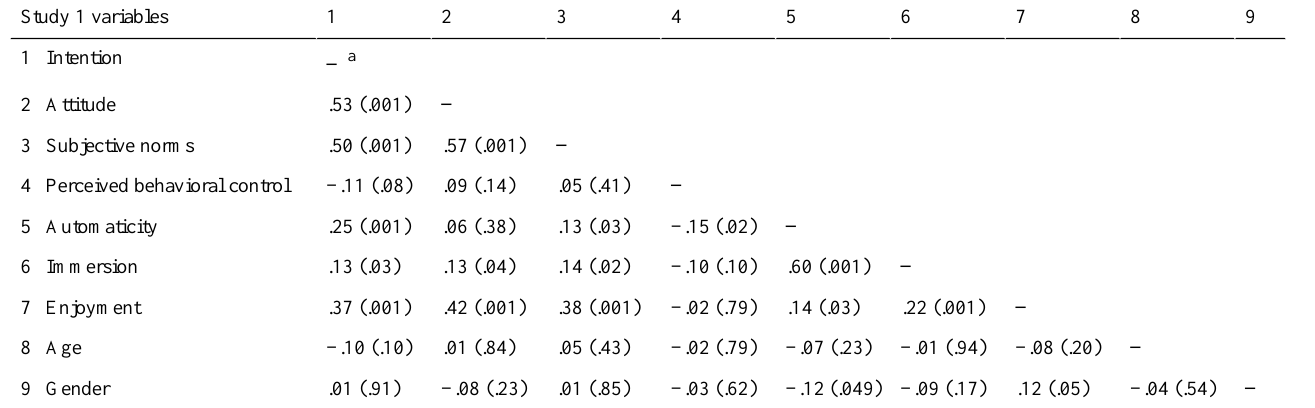
Table 3. Correlation matrix of variables in study 1 (N=262), shown as Pearson correlation coefficient r ( P